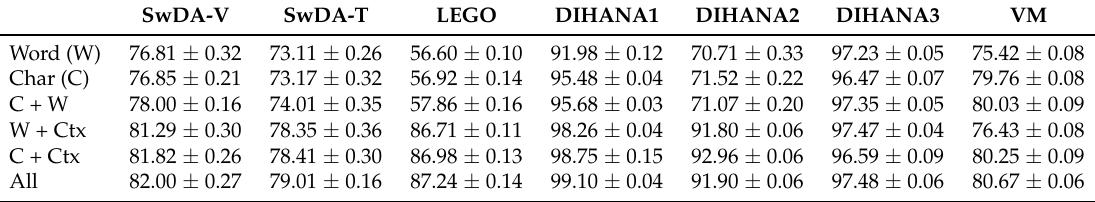
Table 9. Accuracy (%) results obtained using combined information from multiple sources. The first two rows refer to the best results at the word and character levels, respectively. The third row refers to the combination of both approaches. The last three rows include context information